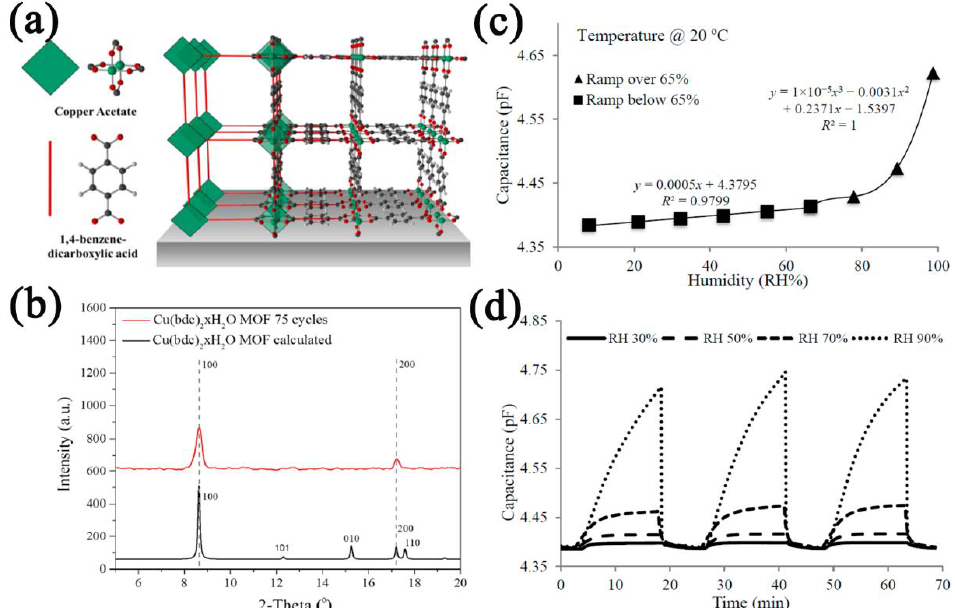
Figure 9. ( a ) Crystal structure, copper acetate, and organic linker of 2D Cu(bdc)·xH 2 O film. ( b ) XRD patterns of Cu(bdc)·xH 2 O film after 75 cycles and simulated. ( c ) Response curve of Cu(bdc)·xH 2 O − based sensor to humidity in the range of 11 – 100% RH. ( d ) Cycling curves of Cu(bdc)·xH 2 O − based sensor. Reproduced with permission from Ref. [95]. Copyright 1996 – 2022, MDPI, Basel, Switzerland.